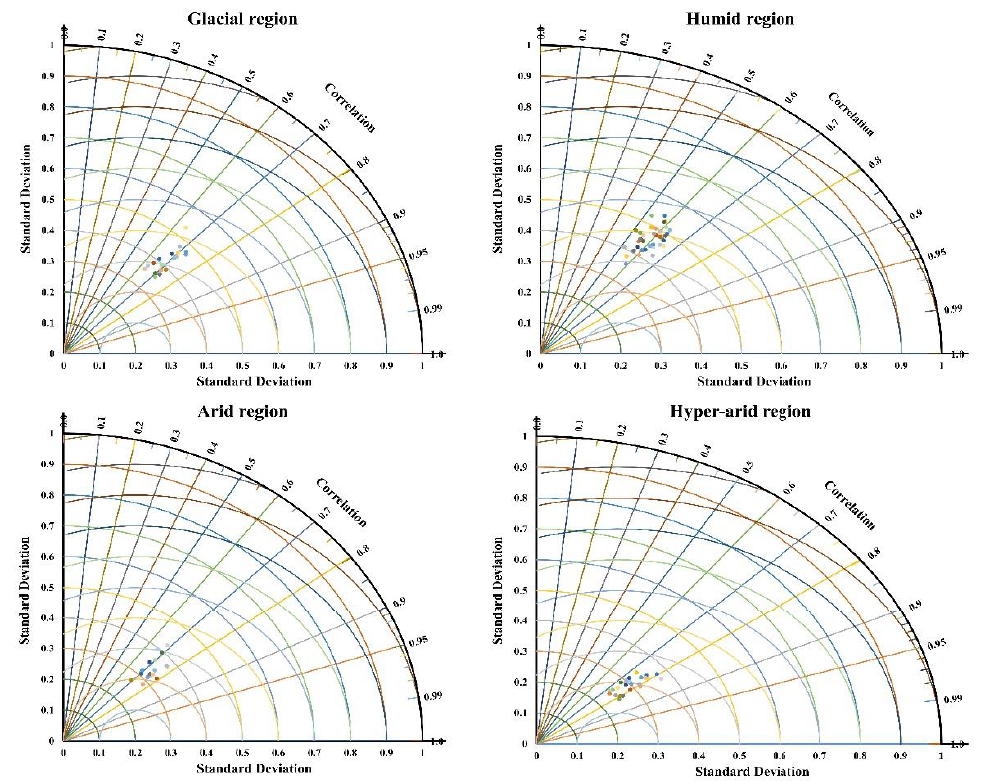
Figure 8. Taylor diagram shows the spatial variability of SPI-1 time-series of RWALS-MPSD against every RG in each climate region. Table 4. Performance assessment of SPDs/MSPDs on a regional scale using SPI-1 estimated from RGs as a reference.